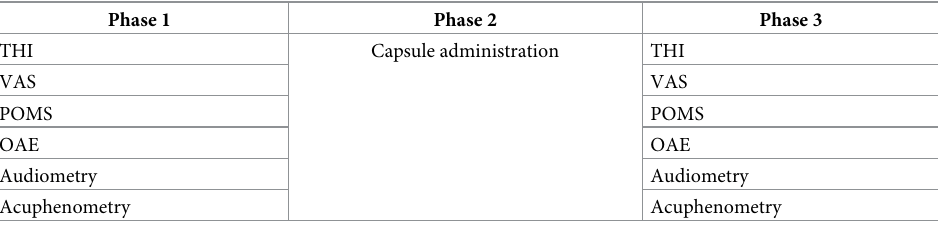
Table 1. Description of the study